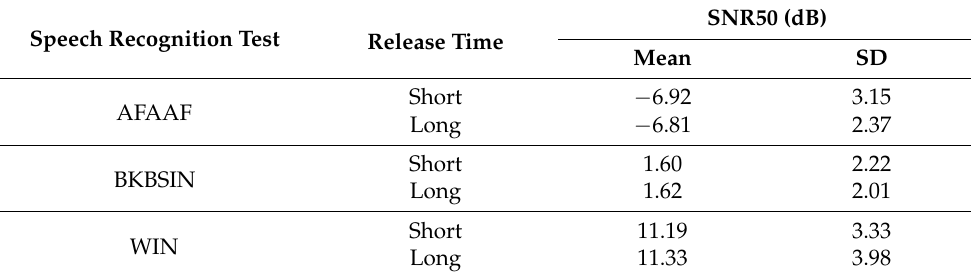
Table 1. Mean SNR50 scores and SDs for the three speech recognition tests (N = 34). Speech Recognition